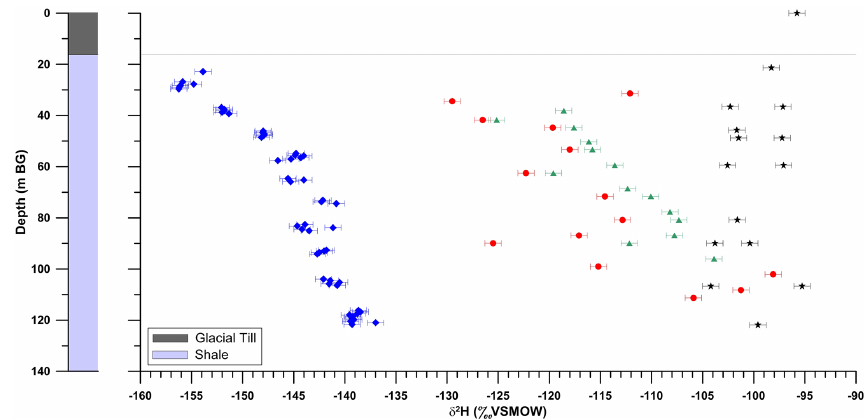
Figure 4. δ 2 H values vs. depth for pore waters measured via vapour equilibration on core samples (solid blue diamonds), trimmed chip samples (solid red circles), and wiped chip samples (solid green triangles) from Cretaceous shale at a site near Luck Lake, Saskatchewan, Canada. The δ 2 H values of the drill fluid are presented as solid black stars. The analytical error is presented as horizontal bars. Gravimetric water content of all samples ranged from 15.5 to 42.2% ( n =